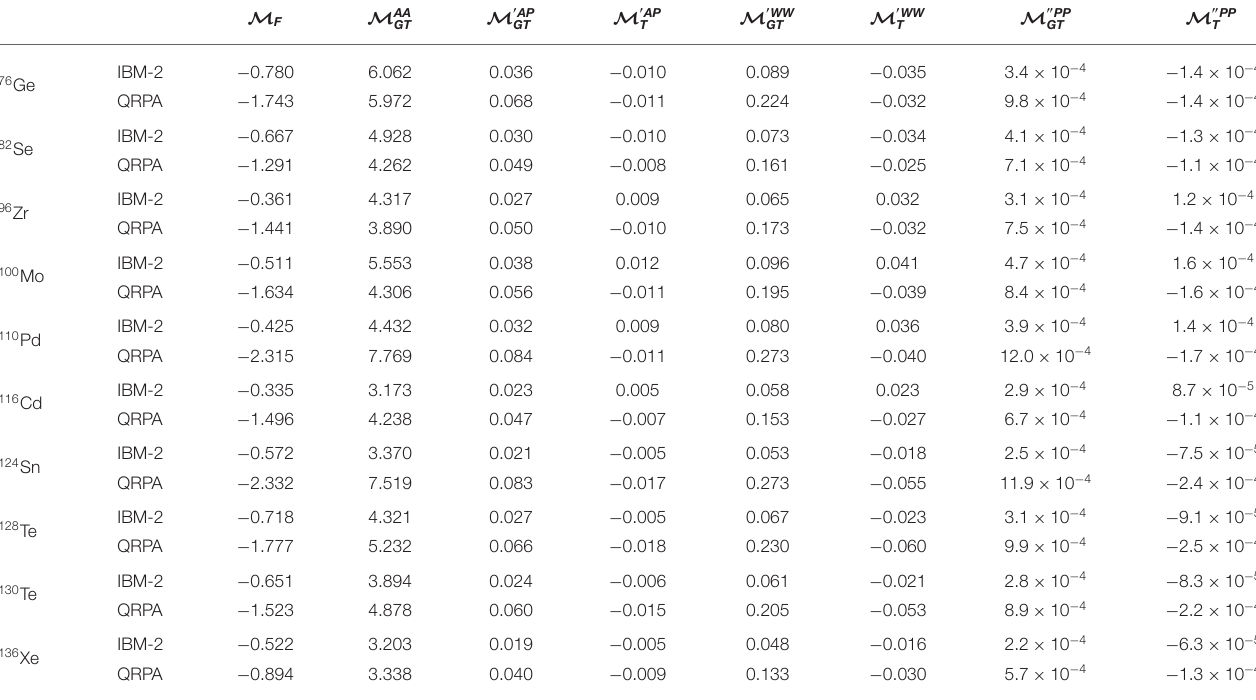
TABLE 2 | Nuclear matrix elements (NMEs) for the standard light neutrino exchange 0 νββ decay mechanism evaluated in the interacting boson model (IBM-2) and quasiparticle random phase approximation (QRPA) as described in the